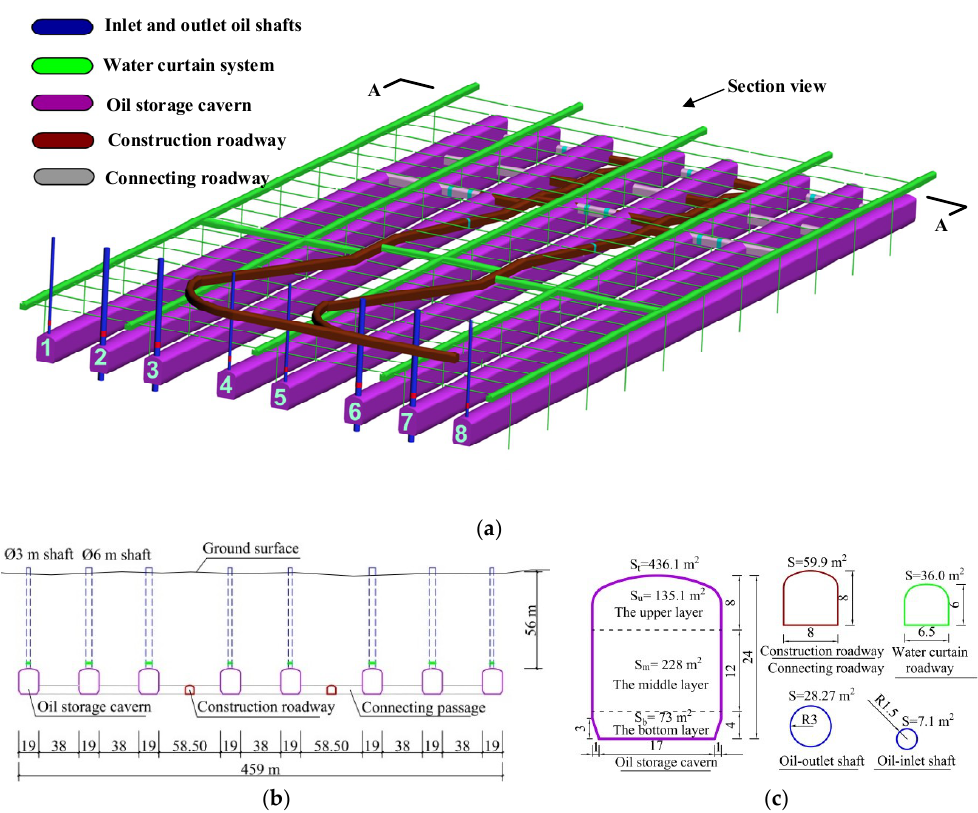
Figure 1. ( a ) Three-dimensional layout of underground structures; ( b ) The profile of oil storage caverns; ( c ) The shape and size of each cavern section.